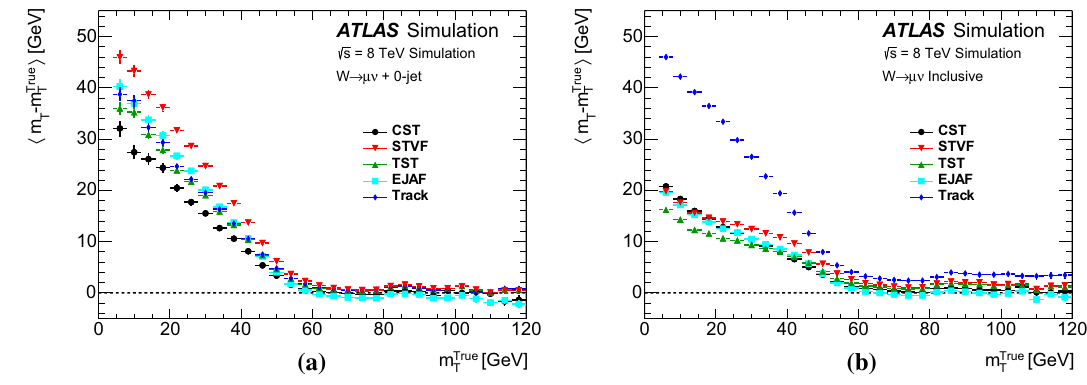
Fig. 12 The resolution of (cid:12)φ( (cid:3) E miss samples